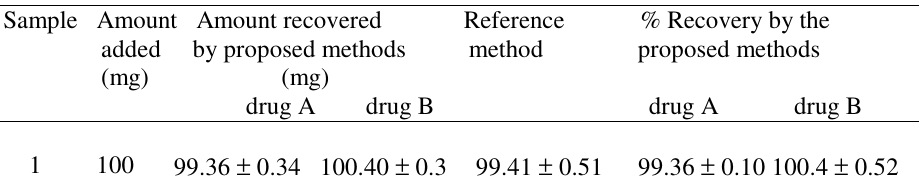
Table 3. Recovery Studies of Famciclovir and